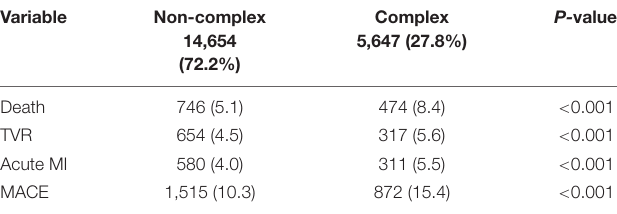
TABLE 3 | Complex vs. non-complex outcomes.